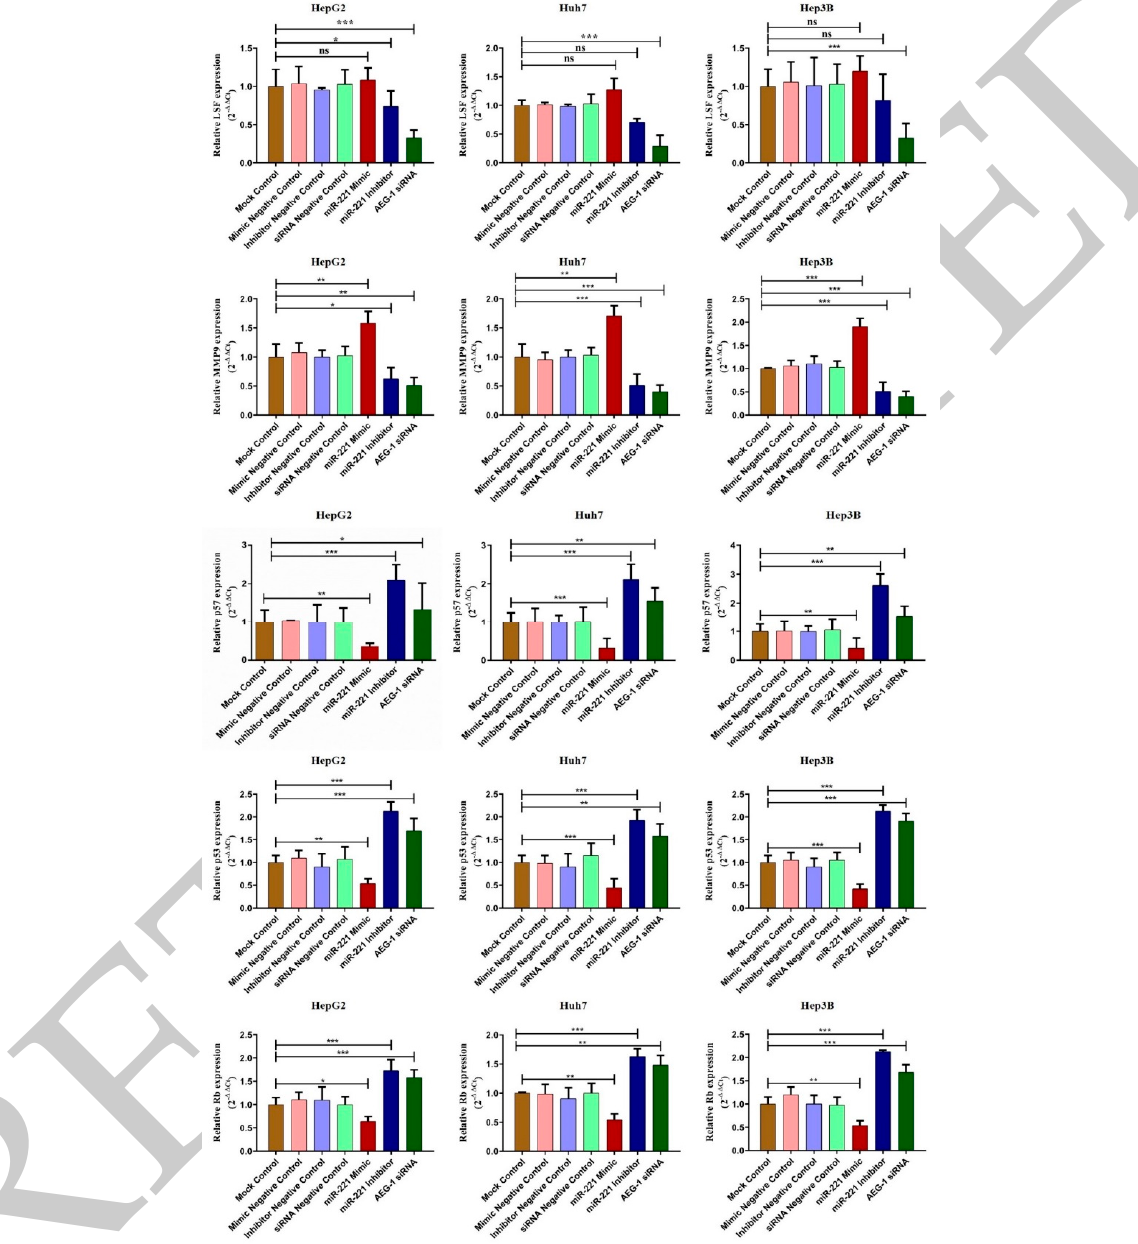
Figure 2. miR-221 / AEG-1 regulates angiogenesis and cell cycle regulatory mRNA expressions in HCC cell line. Expression level of angiogenesis (LSF and MMP9) and cell cycle (p57, p53, and RB) regulatory mRNAs were analyzed by SYBER Green qRT-PCR in mock control, miR-mimic negative control, miR-inhibitor negative control, miR-221 mimic, miR-221 inhibitor, siRNA negative control, and AEG-1 siRNA transfected HepG2, Huh7, and Hep3B cells using GAPDH as an internal control. Error bars are presented as mean ± s.d. and * p < 0.05, ** p < 0.01, *** p < 0.001 compared with NC group. ns: